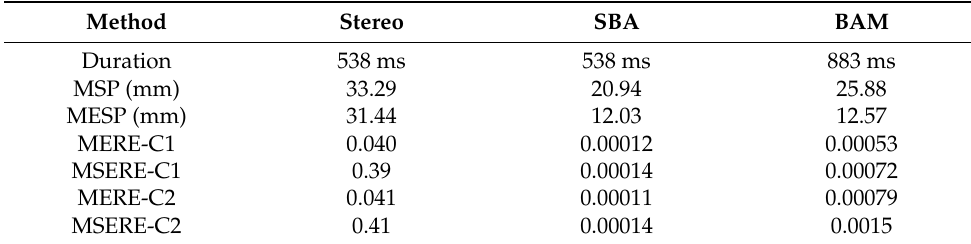
Table 1. Accuracy evaluation of The related data of the mean error of position (MEP), mean square error of position (MSEP), mean error of reprojection error (MERE) and mean square error of reprojection error (MESRE) in pixel are shown in Table 1.